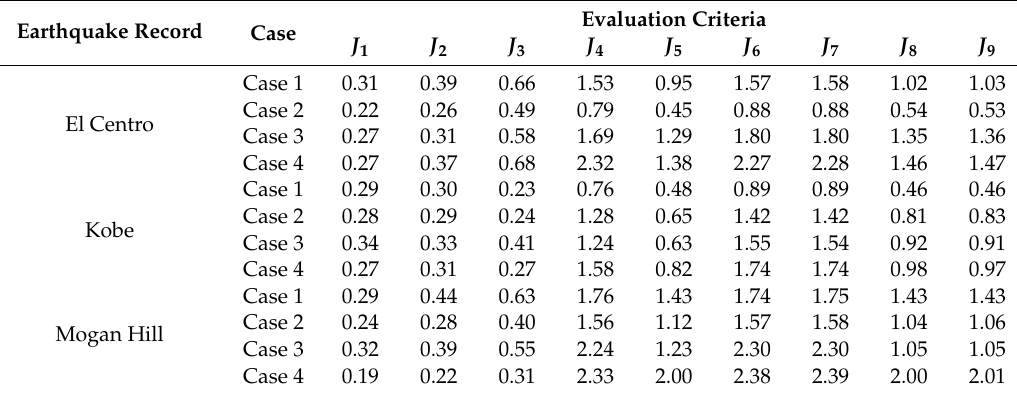
Table 7. Standard deviation of evaluation criteria for perturbed